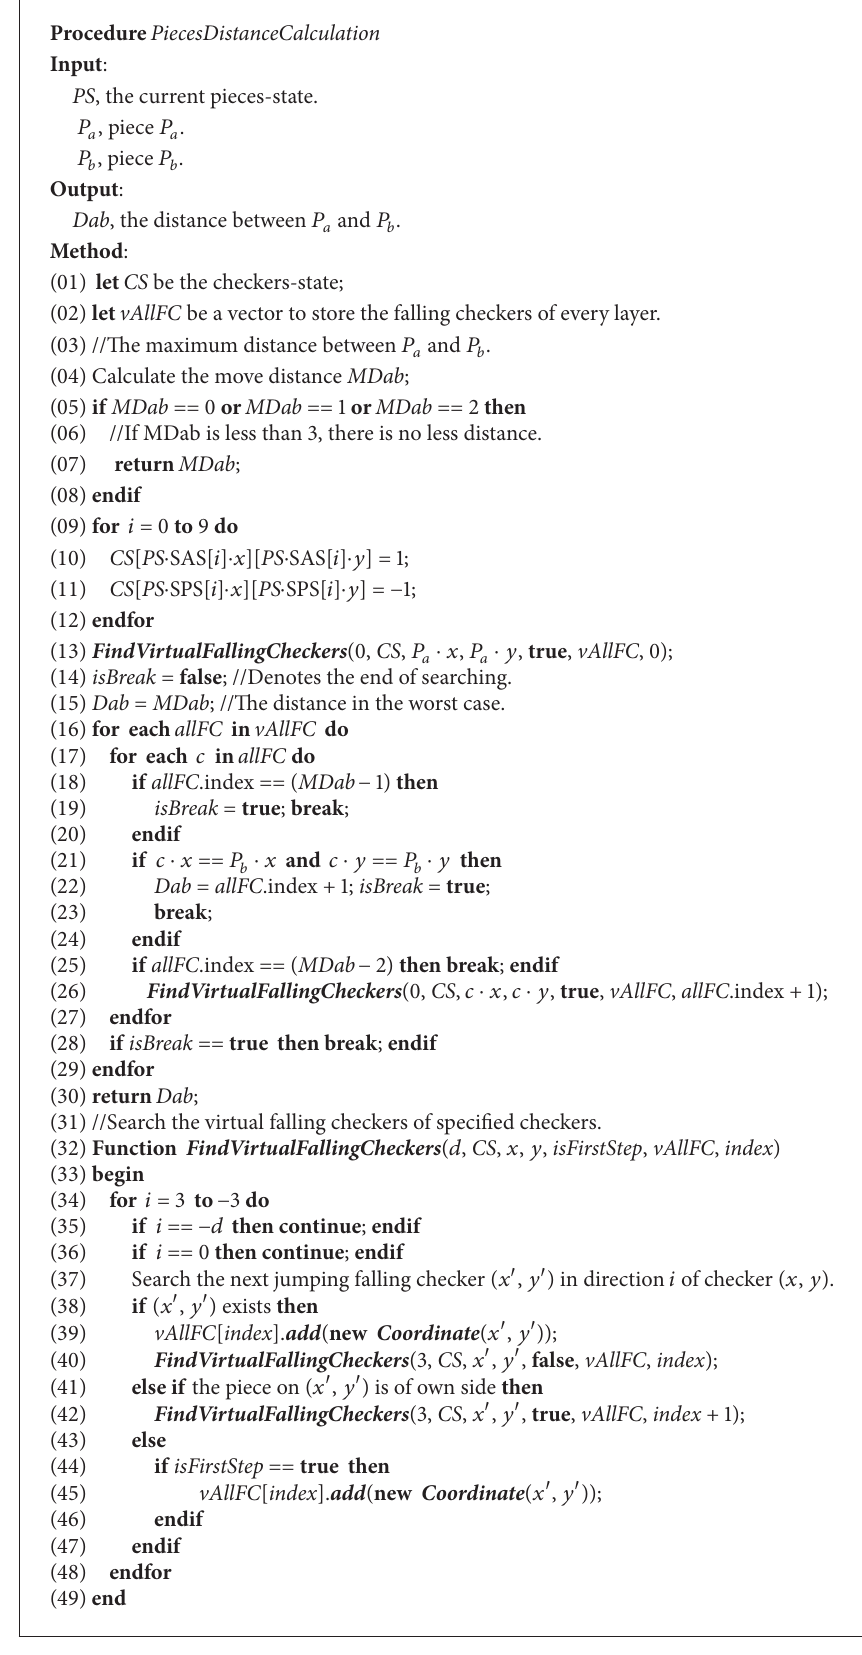
Algorithm 7: PiecesDistanceCalculation